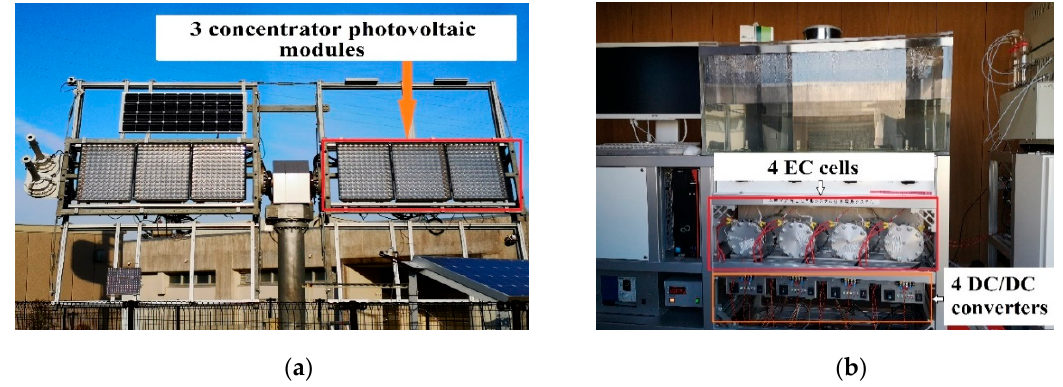
Figure 2. ( a ) View of the concentrator photovoltaics (CPV) outdoor configuration at the University of Miyazaki, Japan, and ( b ) view of 4 sets of DC / DC converters and electrochemical (EC) cells set up used for